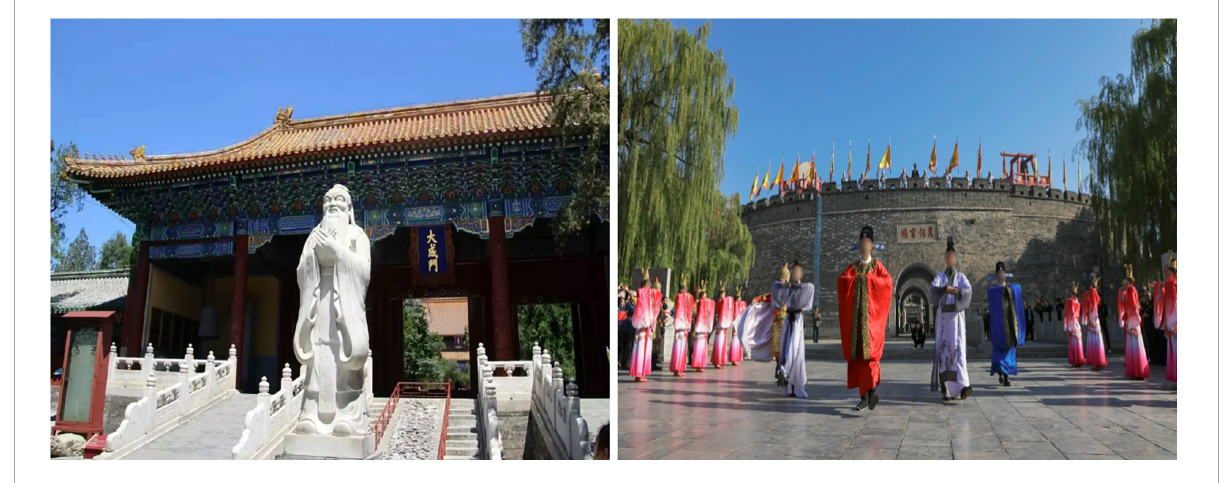
FIGURE3 Heritage tourism in Qufu Sankong Scenic